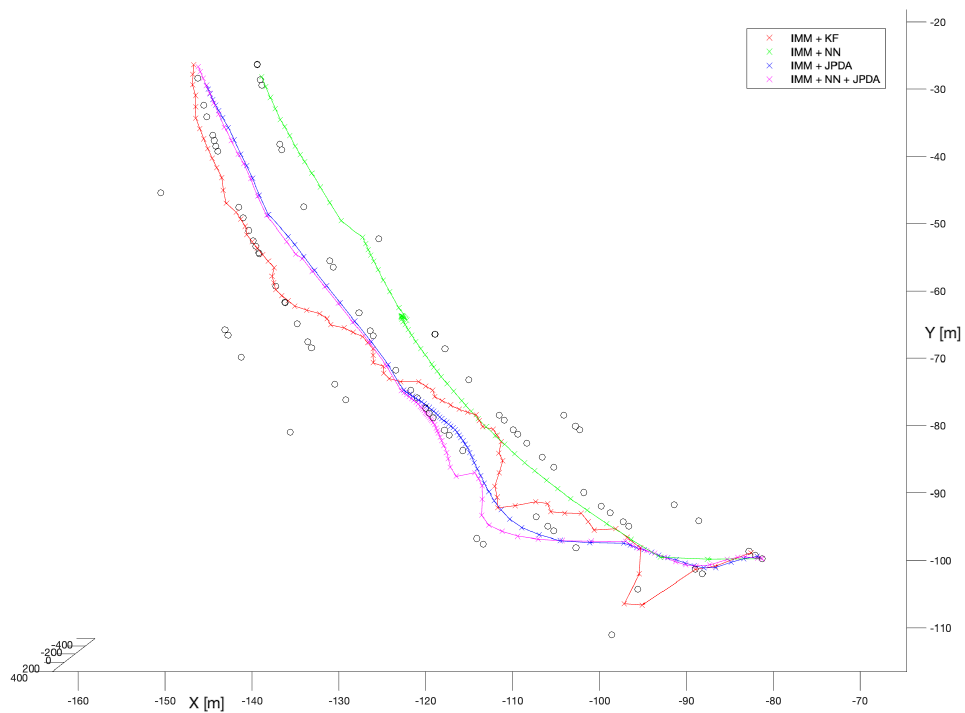
Figure 6. Interacting Multiple Model filters combined with: KF, NN, JPDA, and JPDA + NN, unknown process noise